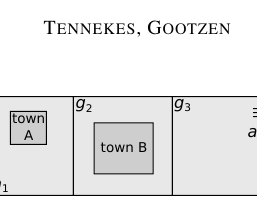
Figure 7: A schematic top view of an island of 1 by 3